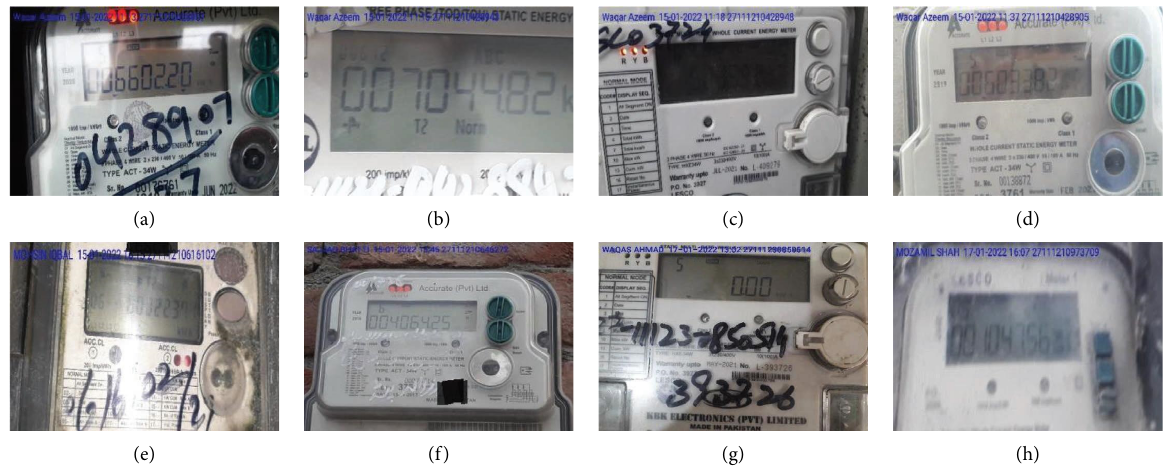
Figure 8: Real-world images, taken in a complex environment. (a) Real-world sample 1. (b) Real-world sample 2. (c) Real-world sample 3.